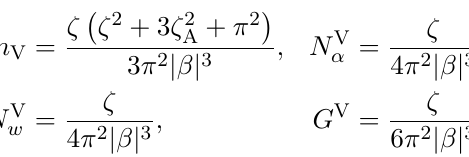
Table 3 . The chiral thermodynamic coefficients up to second order in thermal vorticity of the stress- energy tensor, electric and axial current for a free massless Dirac field (see eqs. (4.5), (4.9), (4.14) for definitions). Here we use T = 1 / β , µ = ζ T and µ A = ζ A T . | | are obtained using the eq.s (4.10)